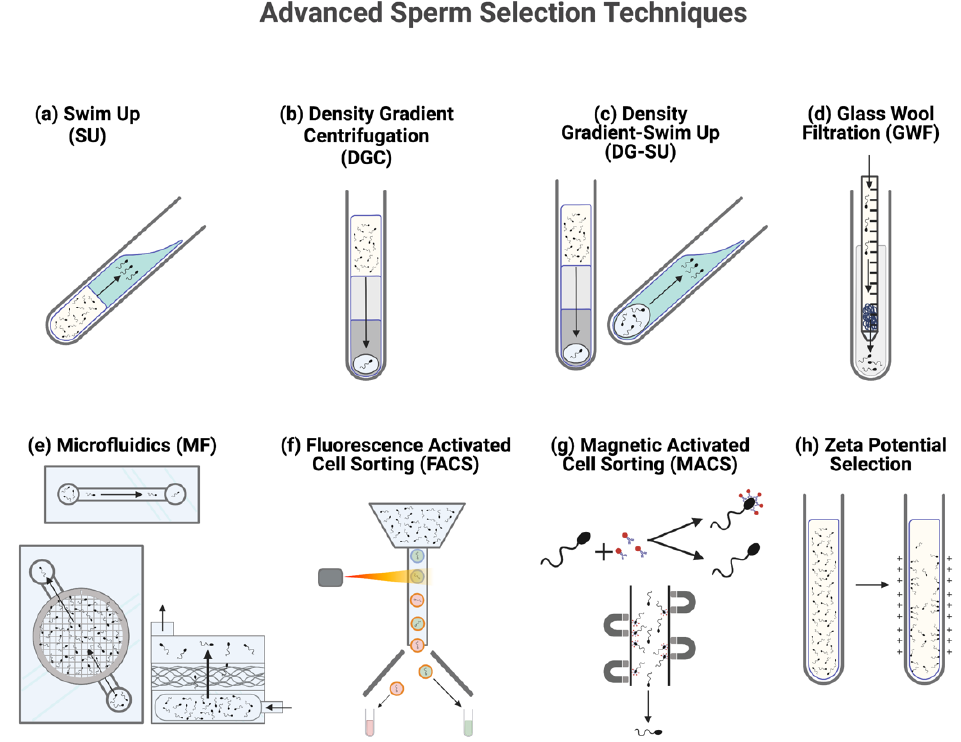
Figure 1. Conventional and novel methods of sperm selection. Selection techniques used to select superior quality sperm include ( a ) Swim Up (SU), ( b ) Density Gradient Centrifugation (DGC), ( c ) Density Gradient-Swim Up (DG-SU), ( d ) Glass Wool Filtration (GWF), ( e ) Microfluidics sorting (MF), ( f ) Fluorescence Activated Cell Sorting (FACS), ( g ) Magnetic Activated Cell Sorting (MACS), and ( h ) Zeta Potential